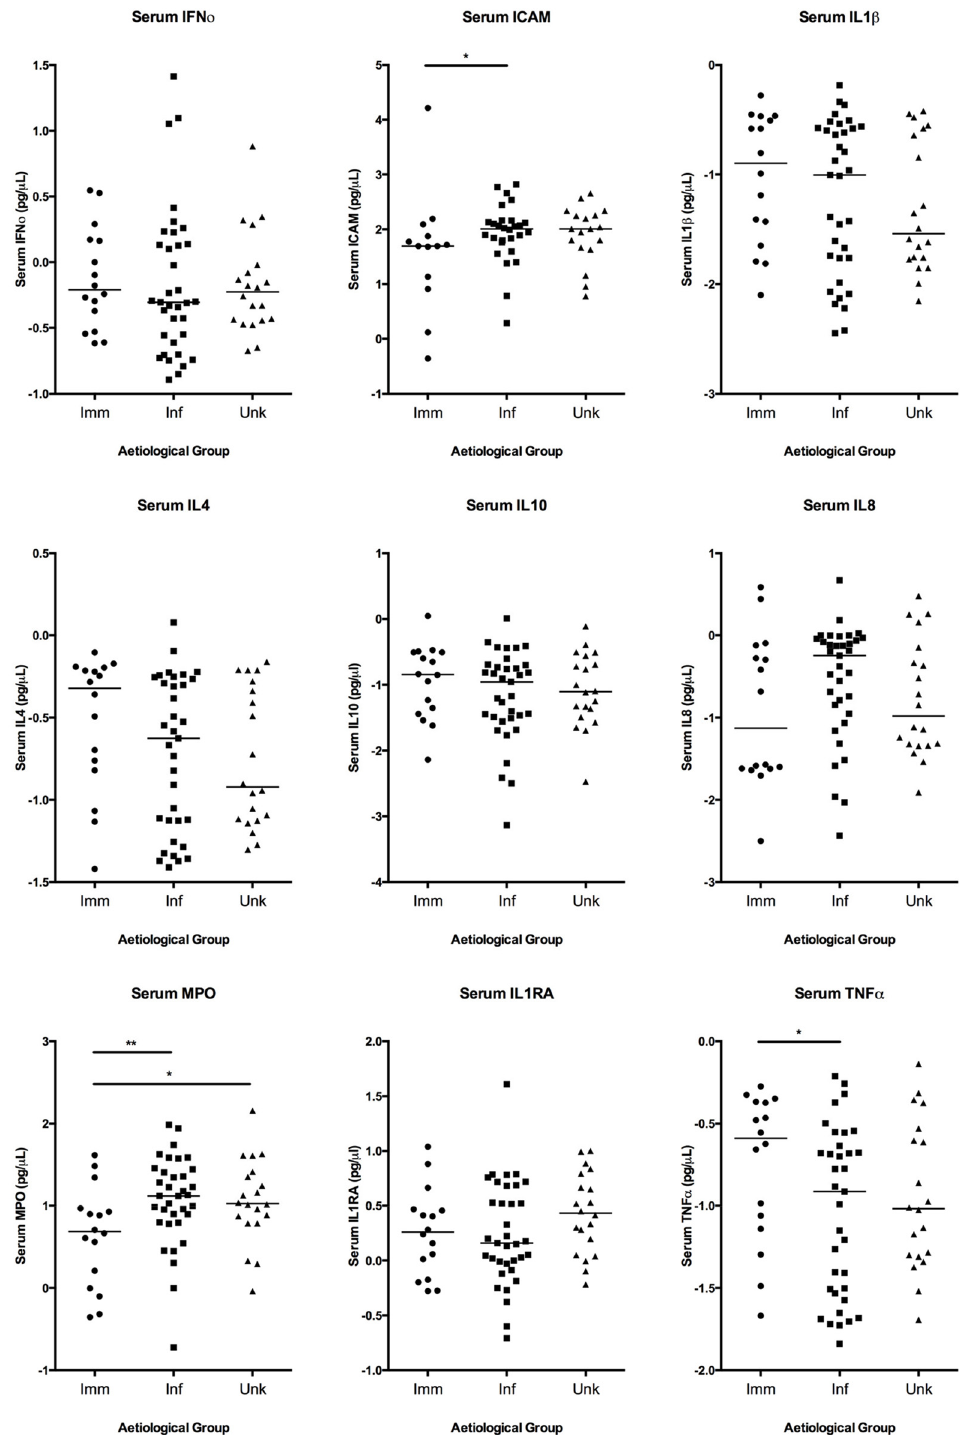
Fig 2. Serum concentrations of mediators in patients with encephalitis of immune-mediated, infectious and unknown aetiology. Bars represent median concentration.